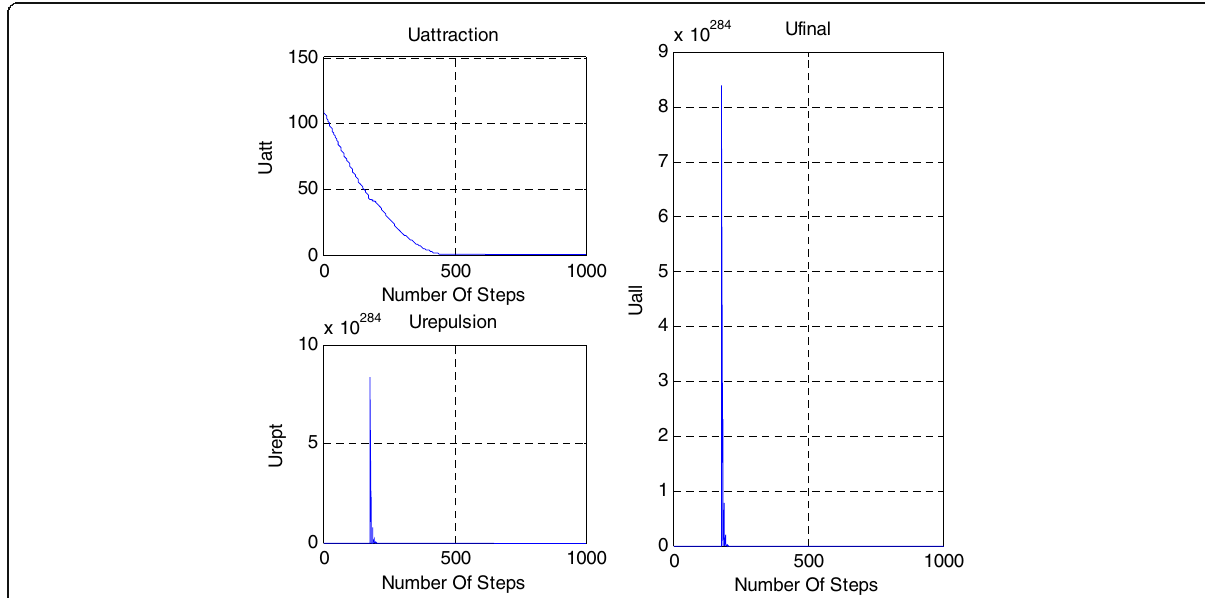
Fig. 27 The energy amount of repulsion and attraction and their yields according to the number of steps in the modified artificial potential field algorithm for the broken line obstacle